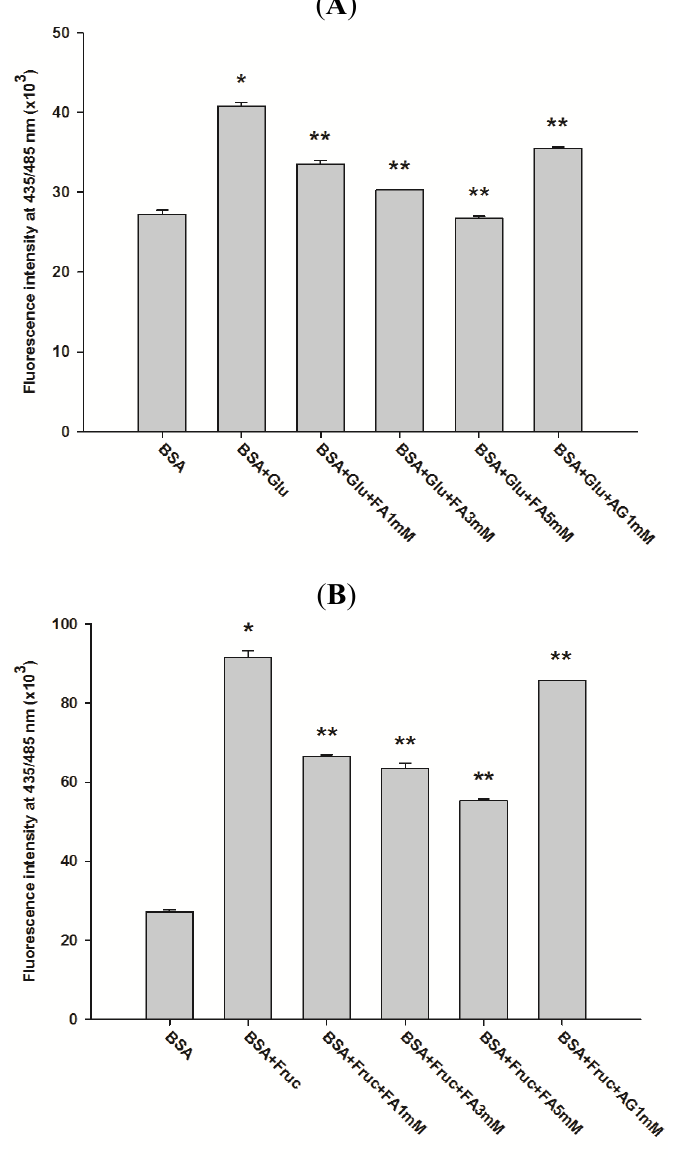
Figure 5. Effect of FA on amyloid cross β -structure levels in BSA incubated with glucose ( A ), fructose ( B ) and ribose ( C ) at week 4. The results are expressed as mean ± SEM ( n = 3). * p < 0.05 when compared to BSA, ** p < 0.05 when compared to BSA+glucose, BSA+fructose or BSA+ribose. AG was used as positive